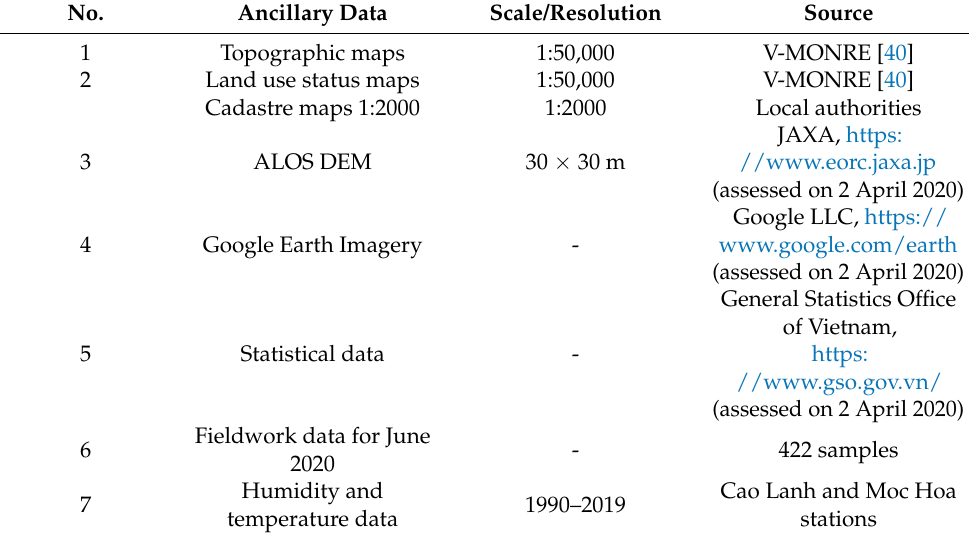
Table 2. The ancillary data used. ALOS DEM: The Advanced Land Observing Satellite digital elevation